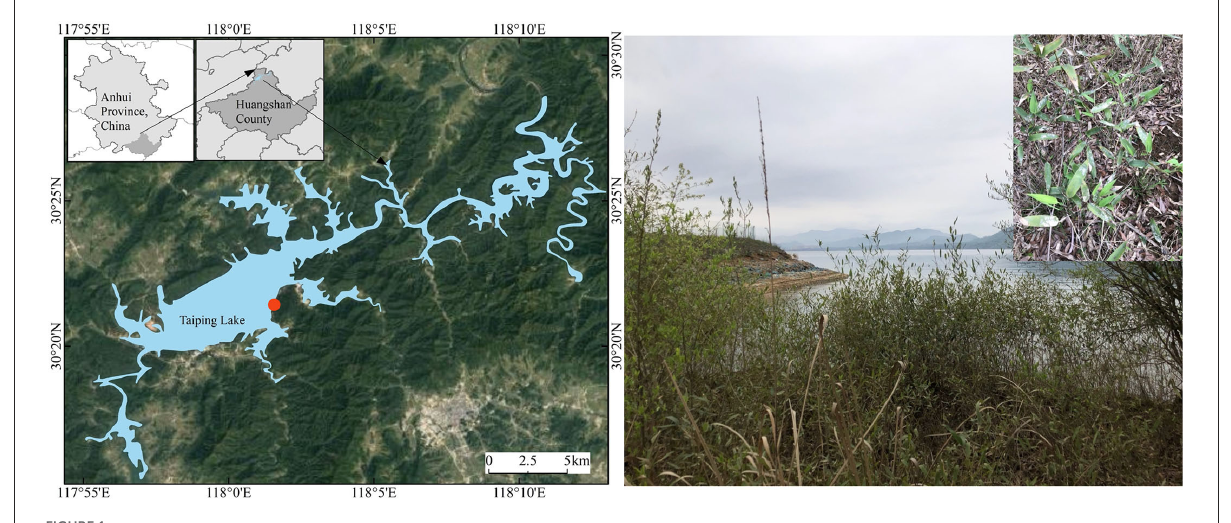
FIGURE1 Taiping Lake location and the detail of the riparian